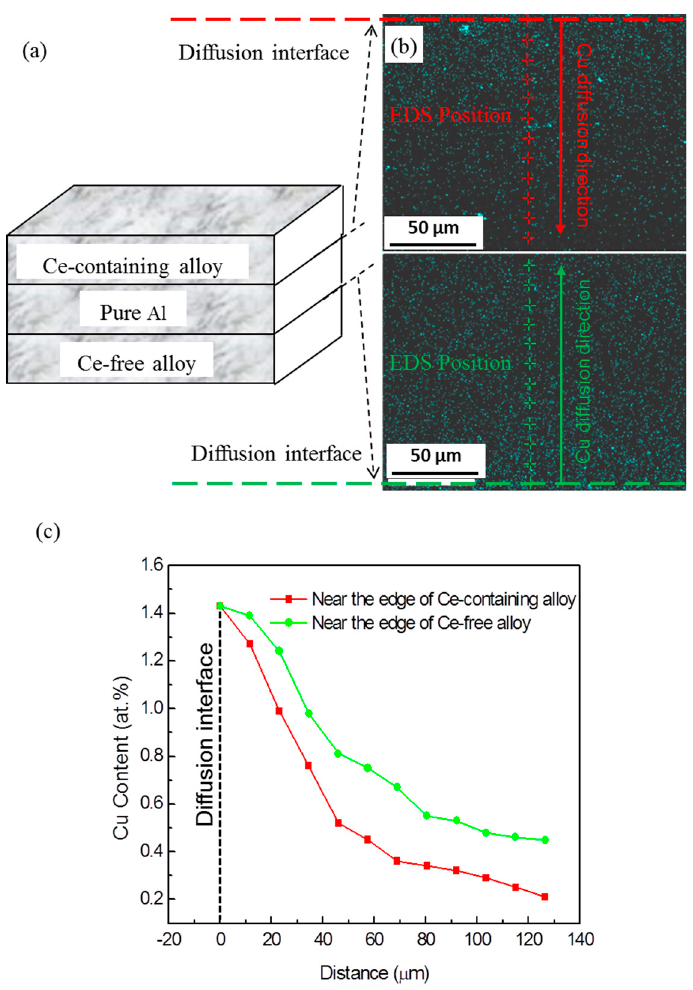
Figure 4. ( a ) Diagram of diffuse couple model; ( b ) mapping of Cu distribution and ( c ) Cu content distribution curve along the solid line arrow in pure Al near the edge of the Ce-containing alloy and the Ce-free alloy respectively.